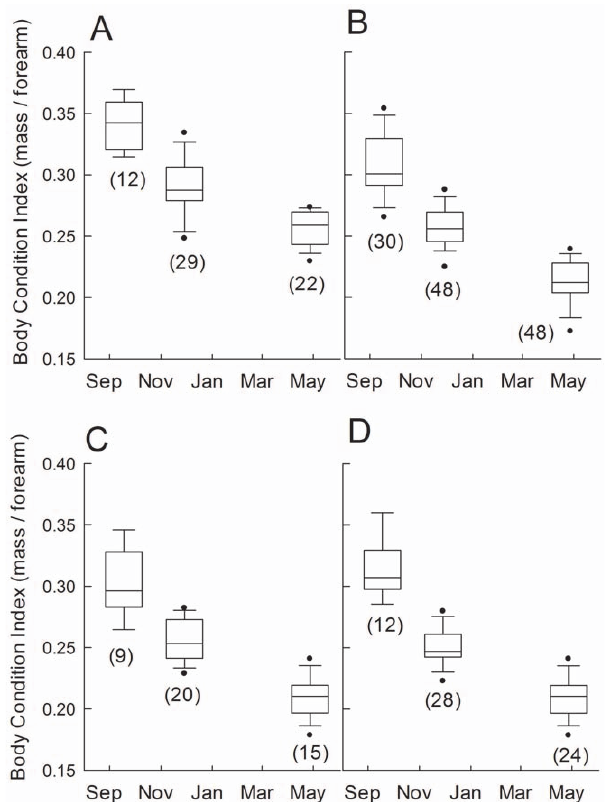
Figure 4. Body condition indices of bats throughout the hibernation period. A) adult females, B) adult males, C) young-of- the-year females and D) young-of-the-year males. Data from all caves are pooled and numbers in brackets represent pooled sample sizes for each sampling period. Boxes depict the 25 th and 75 th percentiles, lines within boxes mark the median, whiskers represent 95 th and the 5 th percentiles and dots indicate outliers.